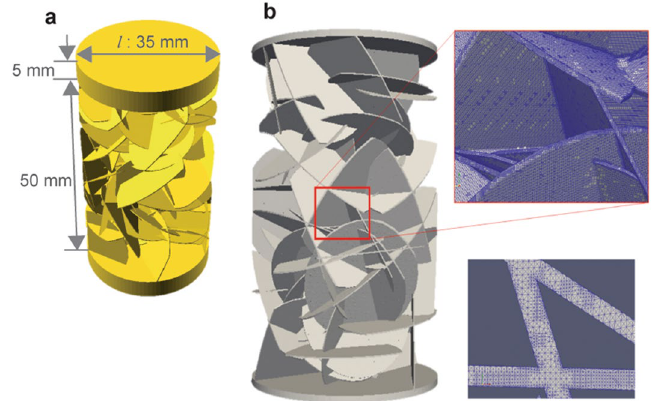
Figure 9. Simulation in OpenFOAM. ( a ) Fracture network with upper and lower boundaries. ( b ) Discretized